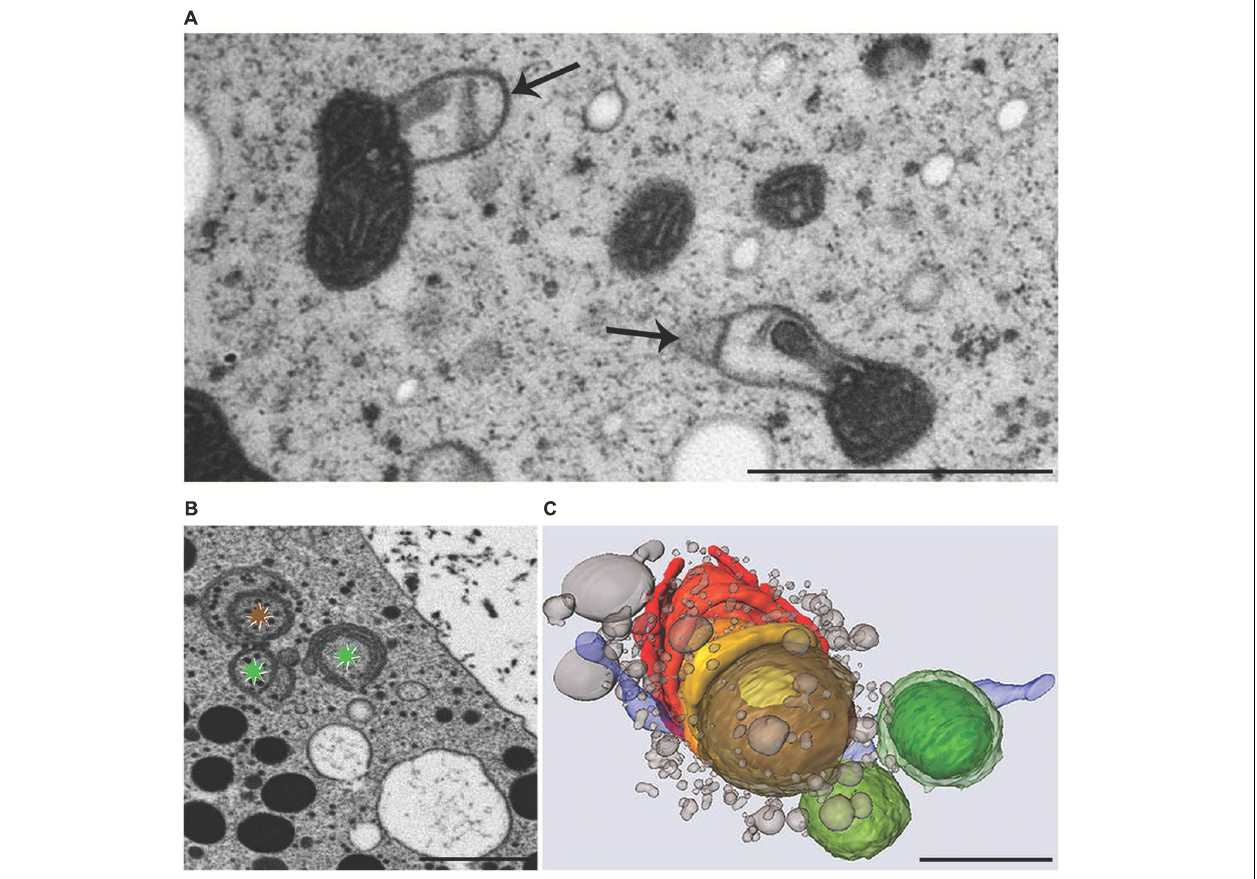
FIGURE 7 | Transmission electron microscopy micrographs of mitochondria (A), FIB-SEM image of degrading dictyosome (B) and 3-D reconstruction of degrading dictyosome from FIB-SEM series (C) after exposure of Micrasterias to KCl. (A) Mitochondria with balloon-like protrusions of outer membrane and condensed matrix. (B) The colored asterisks indicate parts of the dictyosome that are reconstructed in (C) . (C) The reconstruction shows that the dictyosomal cisternae form balls during degradation. Remnants of dictyosomal cisternae in red, ER in blue, small vesicles represent degradation products of cisternae. Scale bars are 1 µ m. (B,C) Reprinted with permission from Lütz-Meindl et al. (2015), Copyright © 2015 Royal Microscopical